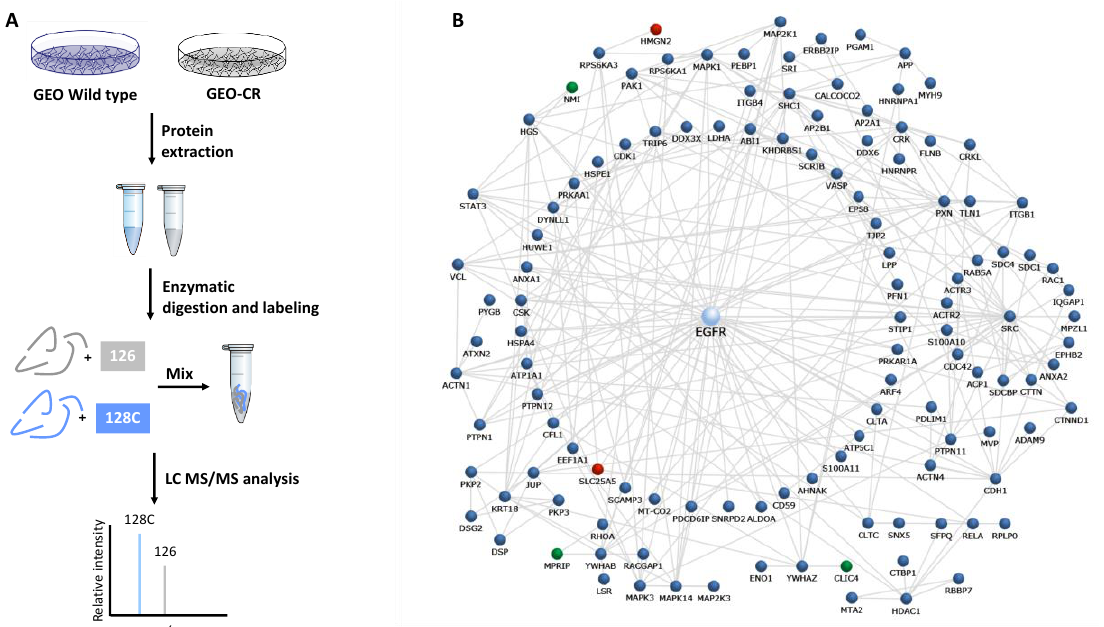
Figure 1. ( A ) Proteomic workflow for the investigation of molecular determinants of acquired resistance to cetuximab. For Tandem Mass Tag (TMT) isobaric labelling, proteins have been extracted from sensitive and cetuximab-resistant GEO cells, digested into peptides and labelled with TMT isobaric stable isotope tags. After mixing, in MS1, the peptides appear as a single precursor. When fragmented during MS2, in addition to the normal fragment ions, the reporter regions dissociate to produce ion signals which provide accurate quantitative information regarding the relative amount of the peptide in the samples. ( B ) Protein interaction network including a subset of proteins identified in GEO colon cancer cells mapping on EGFR1 pathway. Proteins mapping on EGFR1 pathway were identified in both sensitive and cetuximab-resistant GEO cell lines by performing an enrichment analysis against the human cancer and immune signaling pathways “NetPath” (Figure S3). These proteins were then mapped on the EGFR1 interaction network by the FunRich software. Up- and down-regulated proteins are colored in red and green, respectively. Proteins identified in both sensitive and cancer-resistant GEO cells by LC-MS / MS with no changes in their expression levels are reported in blue. For the network construction clusters with more than two nodes were only included. Interactions from outside the experimental dataset were excluded from the network. Molecules are named according to Funrich software.